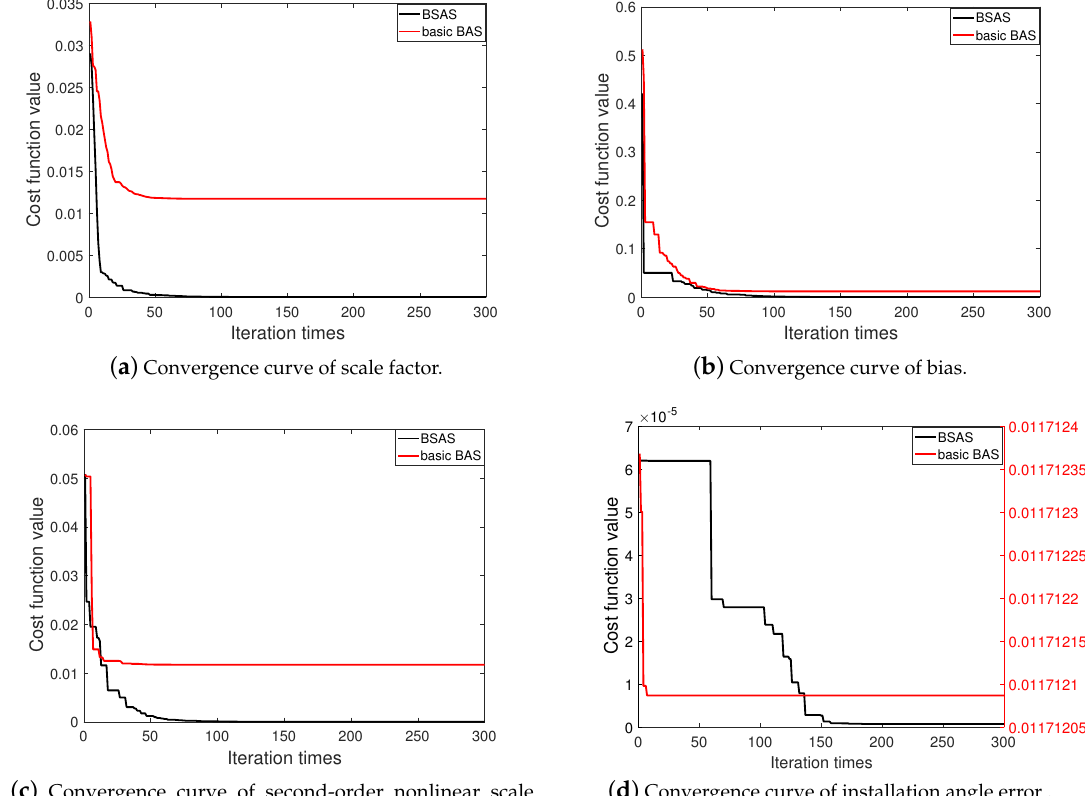
( c ) Convergence curve of second-order nonlinear scale ( d ) Convergence curve of installation angle error . factor. Figure 4. Convergence curve of BSAS and BAS